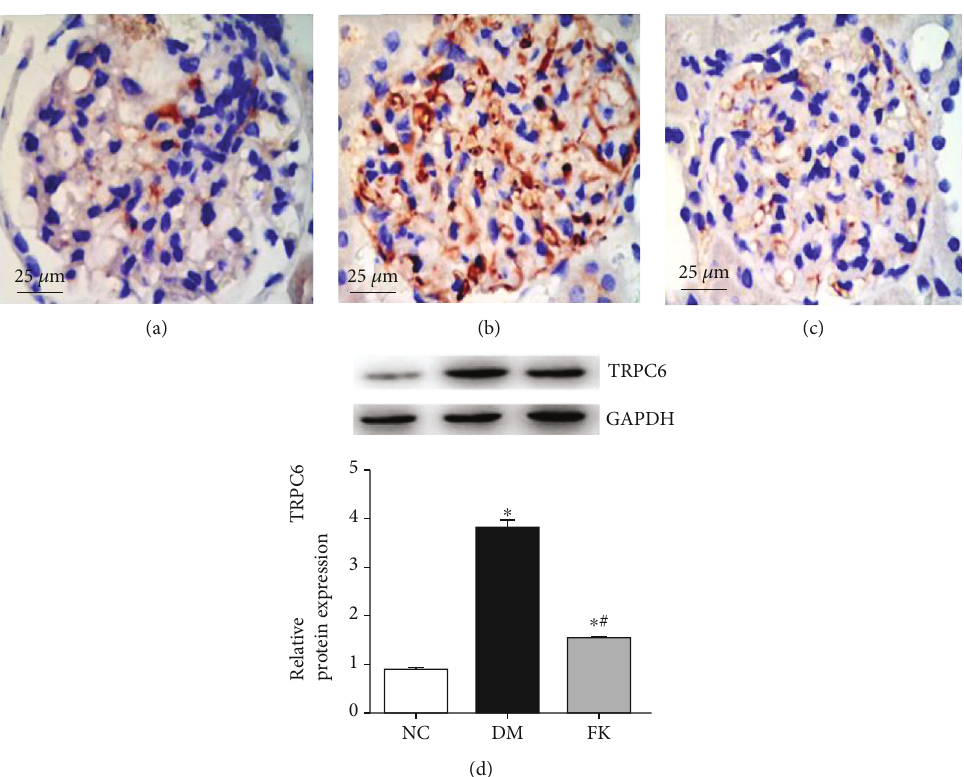
Figure 5: The distribution and expression of TRPC6 observed in the (a) NC group, (b) DM group, and (c) FK group. TRPC6 showed an increased staining intensity in DM rats while FK506 ameliorated this change. ∗ P < 0 : 05 compared to the NC group, ∗ # P < 0 : 05 compared to the DM